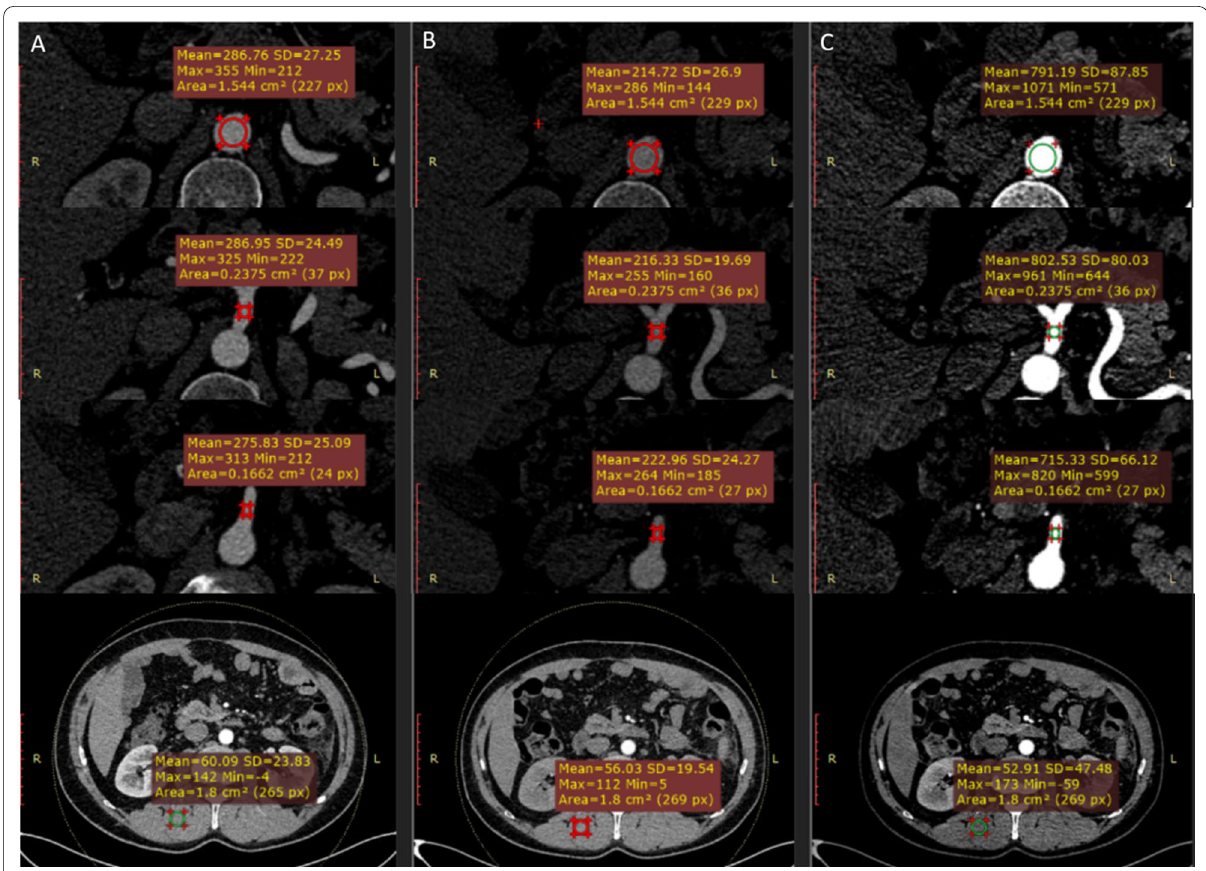
Fig. 1 Quantitative analysis of main branches of abdominal arteries. a – c ND‑CM (0.8 mL/kg, 400 mgI/mL, and 320 mgI/kg), LD‑CM (0.56 mL/ kg, 400 mgI/mL, and 224 mgI/kg), and VMI LD‑CM images in the same patient. Images show the ROI for attenuation measurement at the level + of the aorta (first line), celiac artery (second line), superior mesenteric artery (SMA, third line), and right erector spinae muscle (last line). ND-CM normal‑dose contrast medium, LD-CM low‑dose contrast medium, VMI advanced virtual monoenergetic +